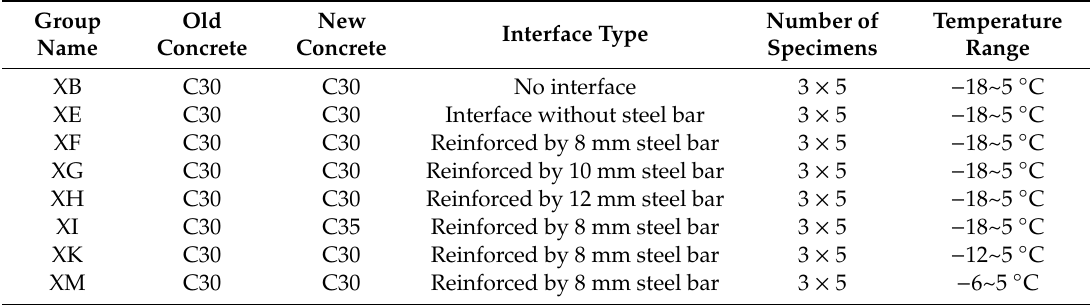
Table 9. Outline of experimental